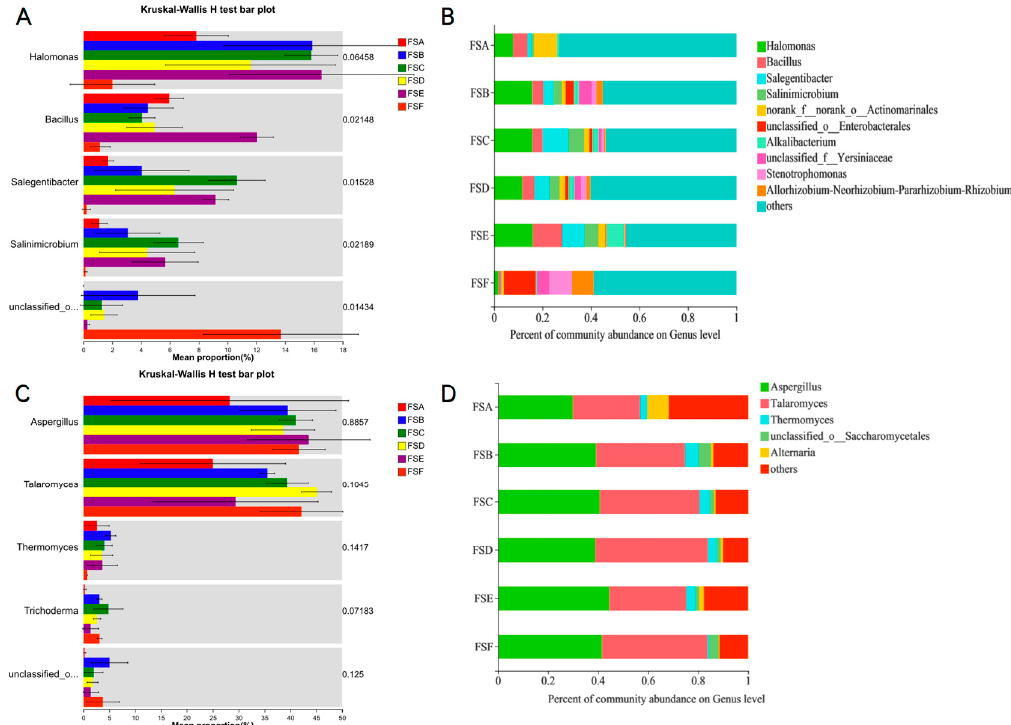
Figure 6. Relative abundance of microbial communities at the genus level in different treatments. Note: ( A ) differences in relative abundance of bacterial communities; ( B ) relative abundance of bacterial community; ( C ) differences in relative abundance of fungal communities; ( D ) relative abundance of fungal community.